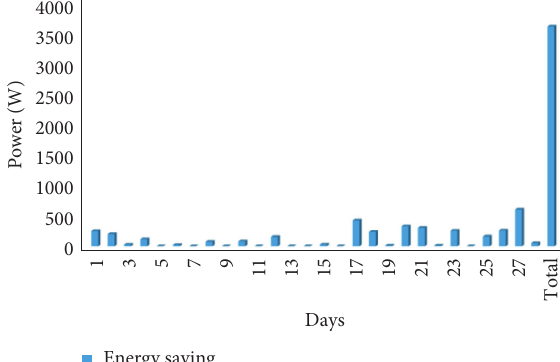
Figure 20: Daily and total power saving for the overall